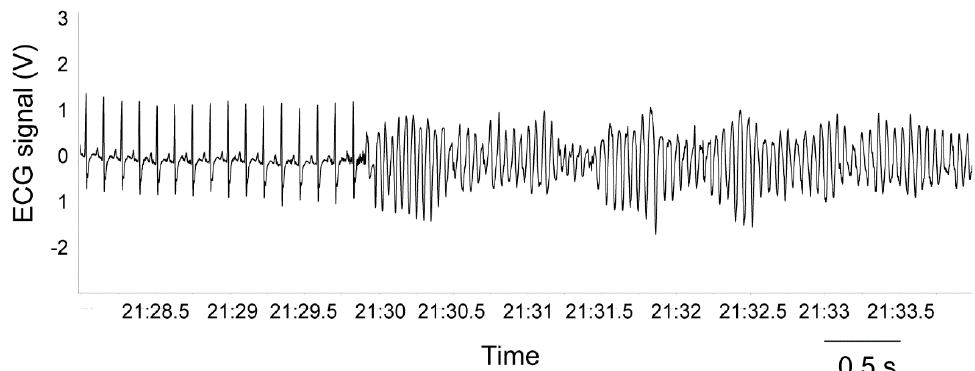
Figure 4. ECG tracing before rat’s death with sustained ventricular tachycardia after administration of the β -adrenergic agonist isoproterenol.